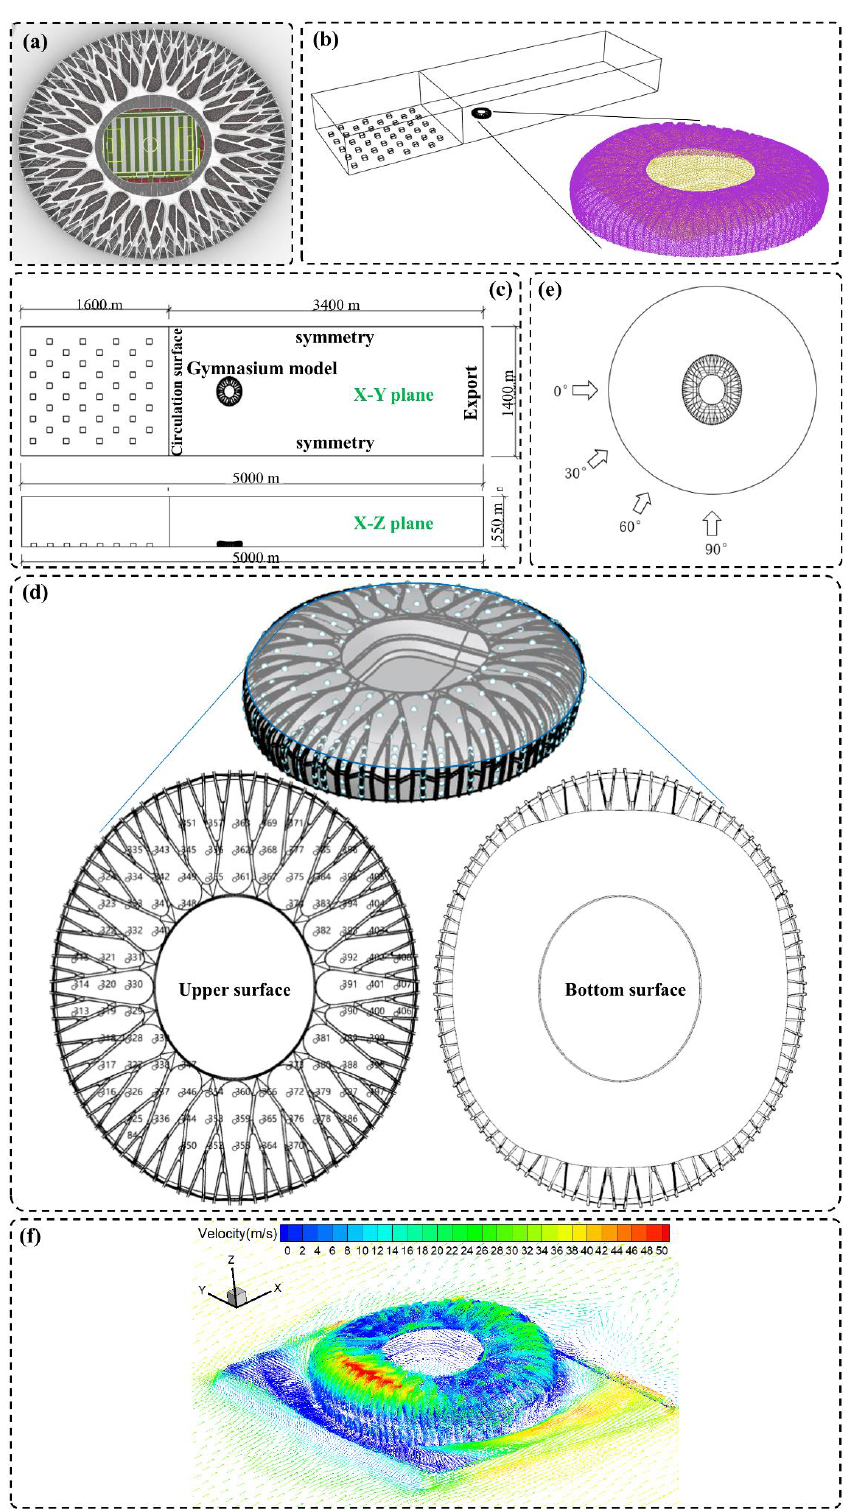
Figure 8. Stadium rendering and numerical simulation diagram: ( a ) render graph; ( b ) computational domain and model surface mesh distribution; ( c ) XY and XZ plane; ( d ) model measurement points arrangement; ( e ) wind direction angle setting; ( f ) wind speed vector